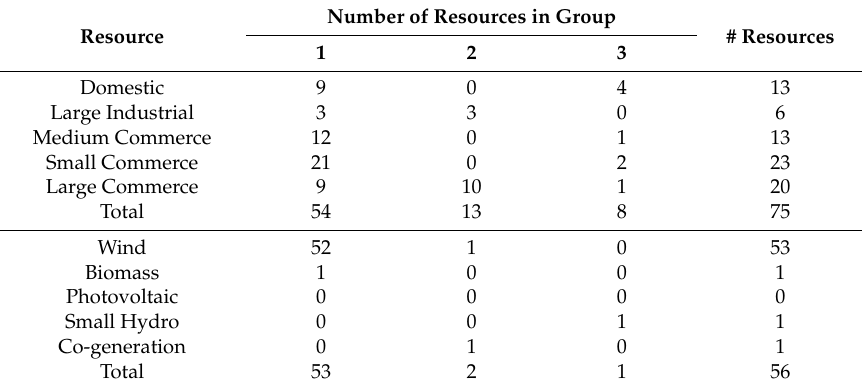
Table 3. Aggregation of resources—Period 20 | K = 3.